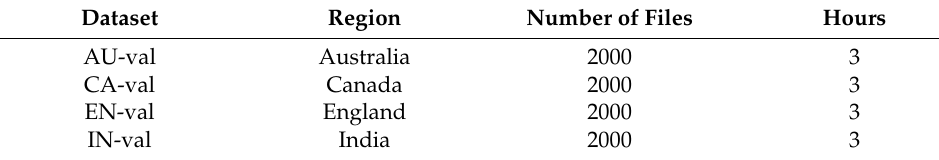
Table 3. Summary of the validation set.